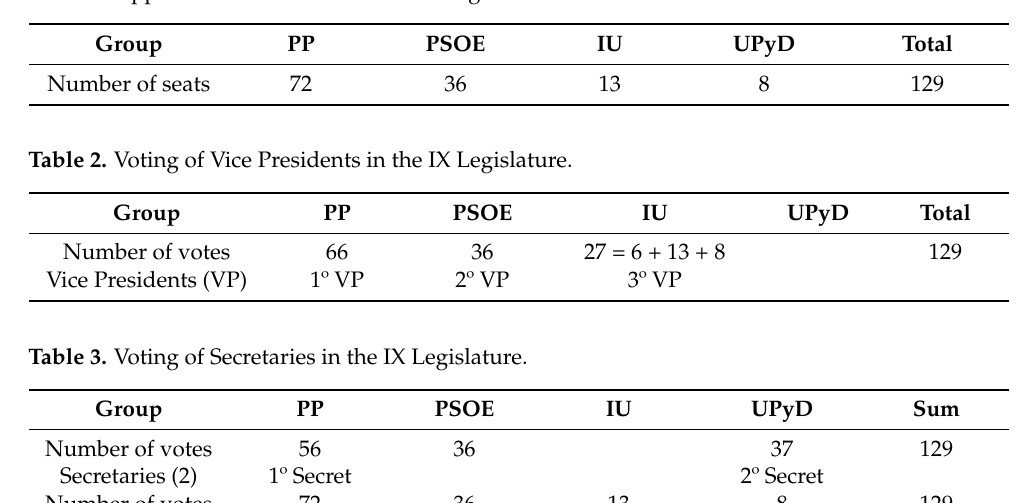
Table 1. Apportionment of seats in the IX Legislature.